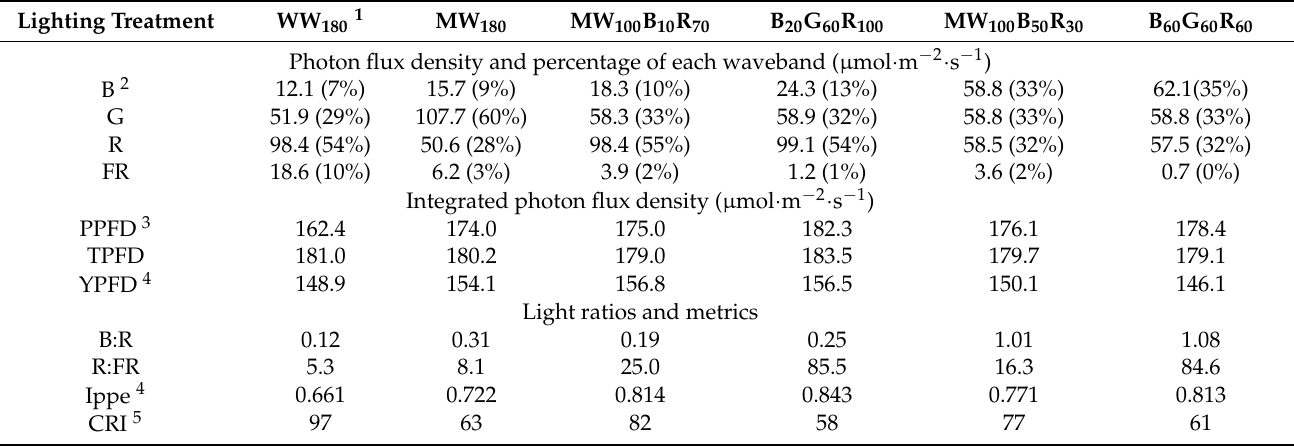
Table 1. Spectral characteristics of six broad-spectrum lighting treatments delivered by warm-white (WW), mint-white (MW), blue (B), green (G), and/or red (R) light-emitting diodes